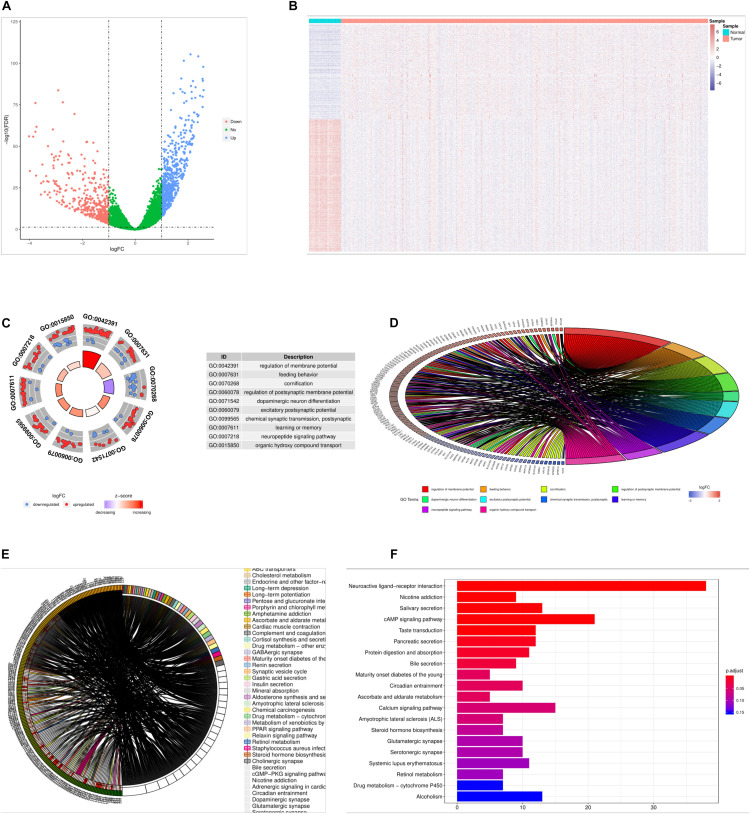
Results of differential gene analysis. (A) volcano plot of differentially expressed genes, the horizontal axis is the differential expression multiple (Log2FC), the longitudinal axis is—log10(fdr), the blue point is the up-regulated gene, and the red point is the down-regulated gene. (B) The heat map of the differentially expressed genes, the horizontal axis is the sample, the longitudinal axis is the different genes, the red indicates the high expression of the gene, and the blue indicates the low expression of the gene. (C) Circle graph of the top 10 GO terms with the most enriched genes. (D) Enriched the first 10 GO term and chord graphs with the largest number of genes, the right semicircle represented 10 GO term, the left semicircle represented the genes enriched in these 10 GO term. (E) Chord diagram of the main KEGG signaling pathway for gene enrichment. (F) Top 20 KEGG pathway, with the largest number of enriched genes, the horizontal axis of the map indicated the number of genes enriched, and the longitudinal axis indicated the names of each species.